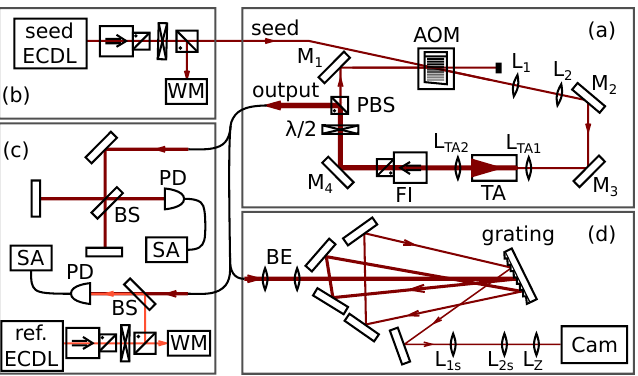
Figure 1: Schematic of the FSF laser and characterization tools. (a) cavity of the FSF laser, (b) seed laser, (c) radio frequency characterization setup, (d) grating